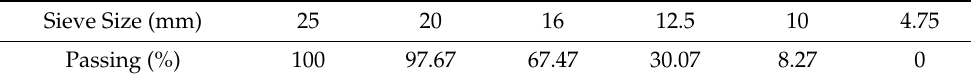
Table 2. Coarse aggregate